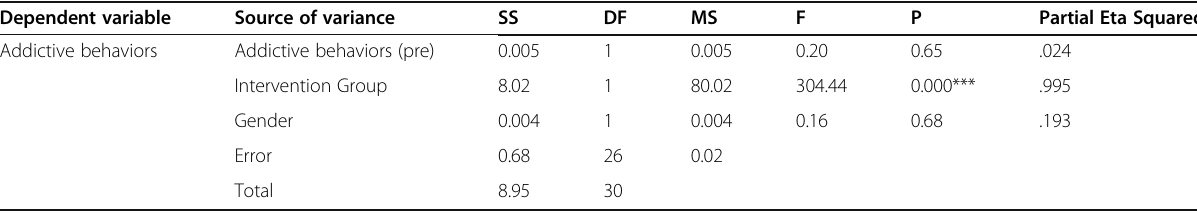
Table 3 ANCOVA test for addictive behaviors due to study variables Dependent